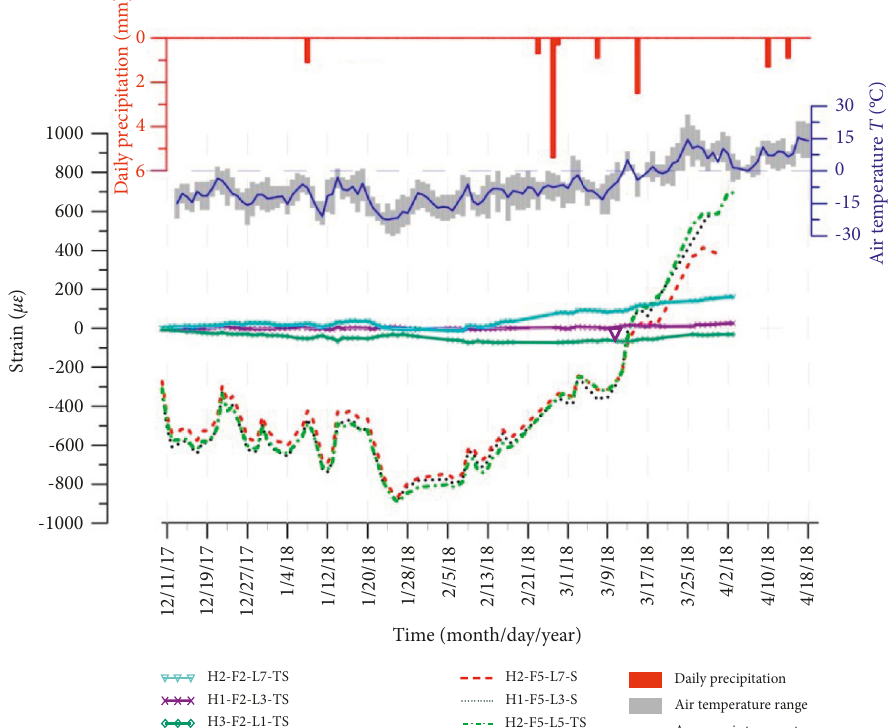
Figure 10: Curves of soil deformation in the F5 and F2 layers of the roadbed under climatic conditions.